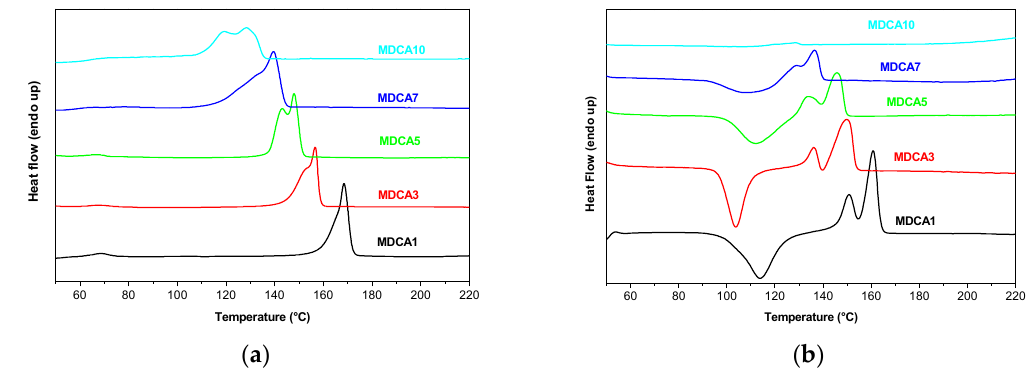
Figure 4. Differential scanning calorimetry (DSC) curves of the first heating ( a ) and second heating ( b ) scans of samples MDCA1–MDCA10: the curves are vertically shifted for clarity.